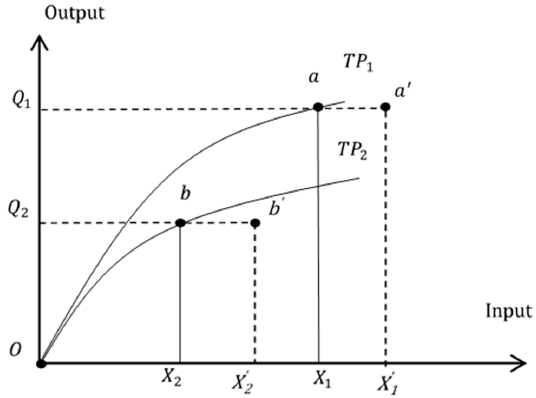
Figure 1. Production frontiers of two senior care facilities, TP 1 and TP 2 .